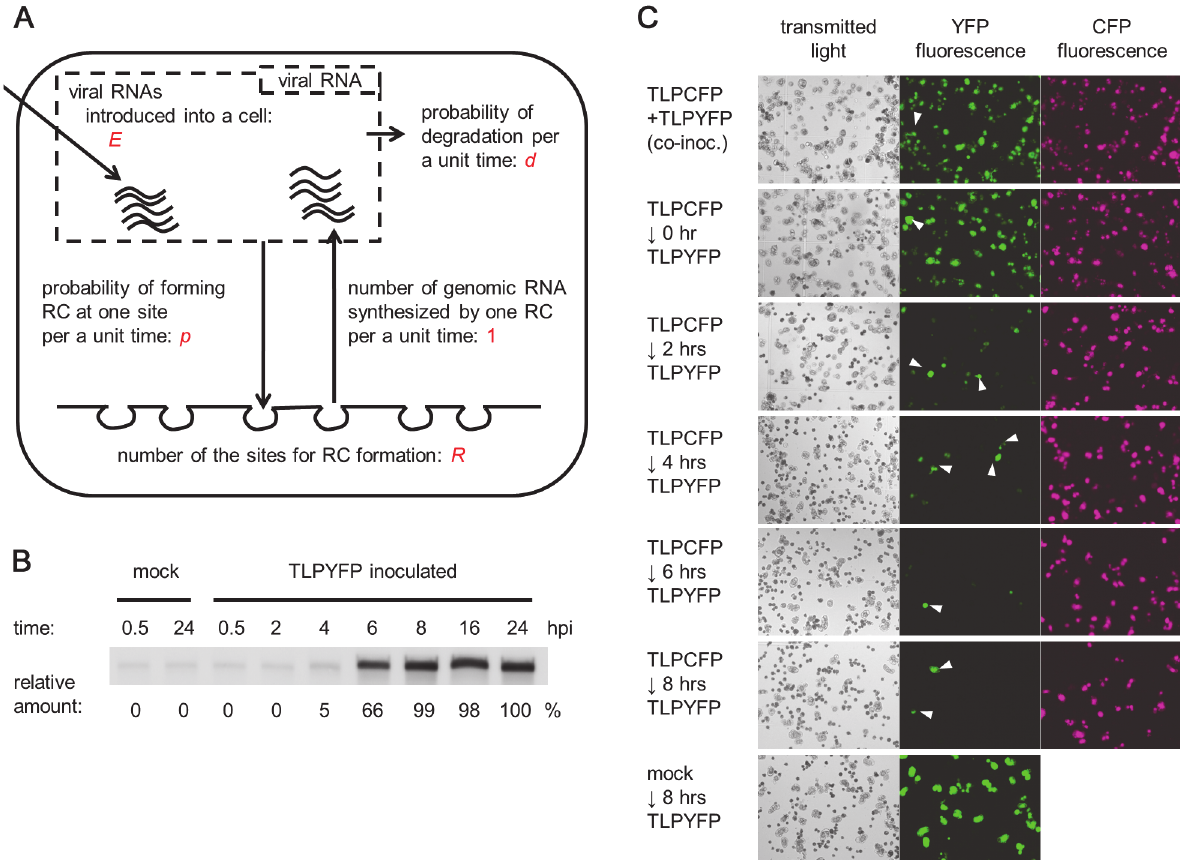
Fig 2. A model for single-cell infections. (A) A model for single-cell infections. (B) The accumulation of complementary-strand RNA at different time points. The results of northern blotting are shown, and the amount of complementary-strand RNA relative to that at 24 hpi is shown below the image. (C) Challenge inoculation with TLPYFP to TLPCFP-inoculated cells. Protoplasts were first inoculated with TLPCFP, followed by TLPYFP after the indicated intervals. Exceptionally, top panels show co-inoculation of TLPCFP and TLPCFP, and bottom panels show inoculation with TLPYFP 8 h after mock